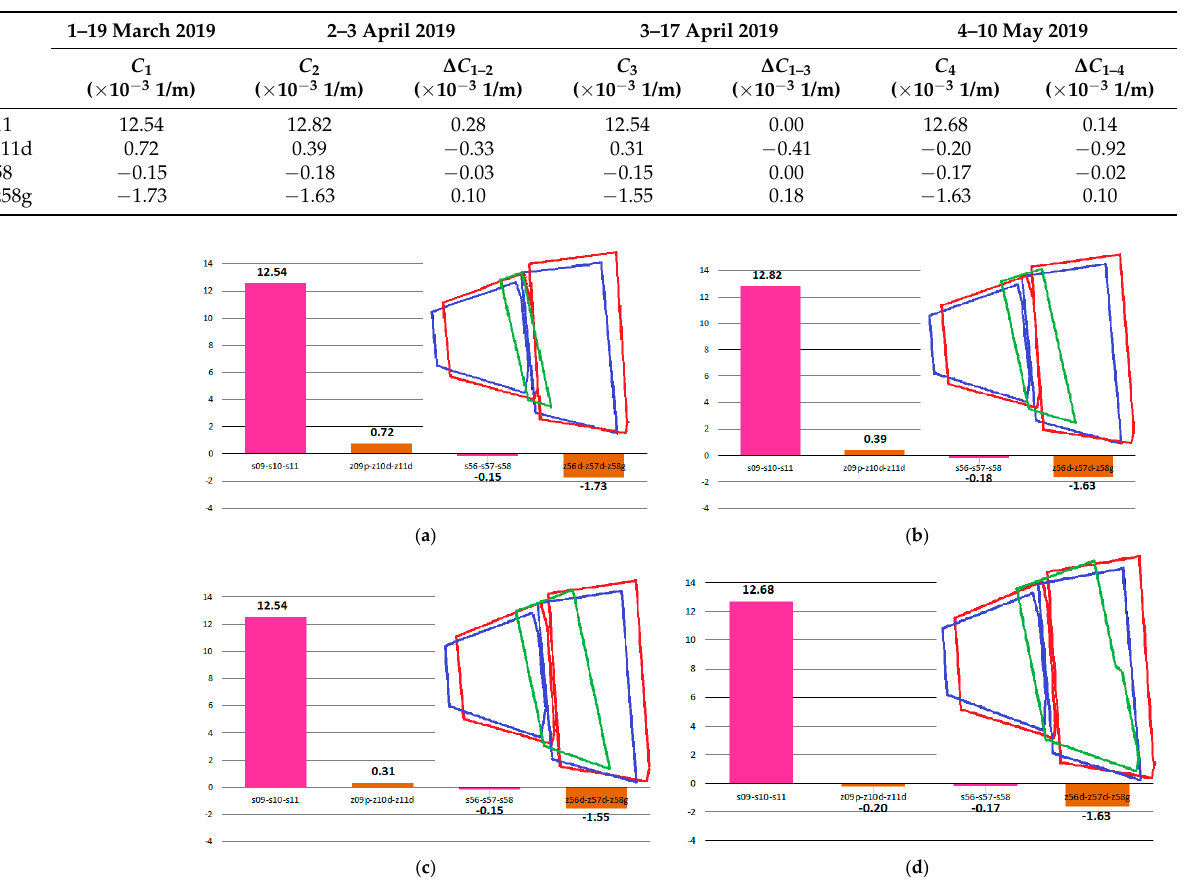
Figure 9. The values of curvatures (vertical axis) observed on two neighboring, ground sections— brown color and wall sections—pink color (horizontal axis) in the time period of March–May 2019, and the progress of the 1/II longwall in the 405/1 hard coal seam: ( a ) 19 March 2019; ( b ) 3 April 2019; ( c ) 17 April 2019; ( d ) 10 May 2019.